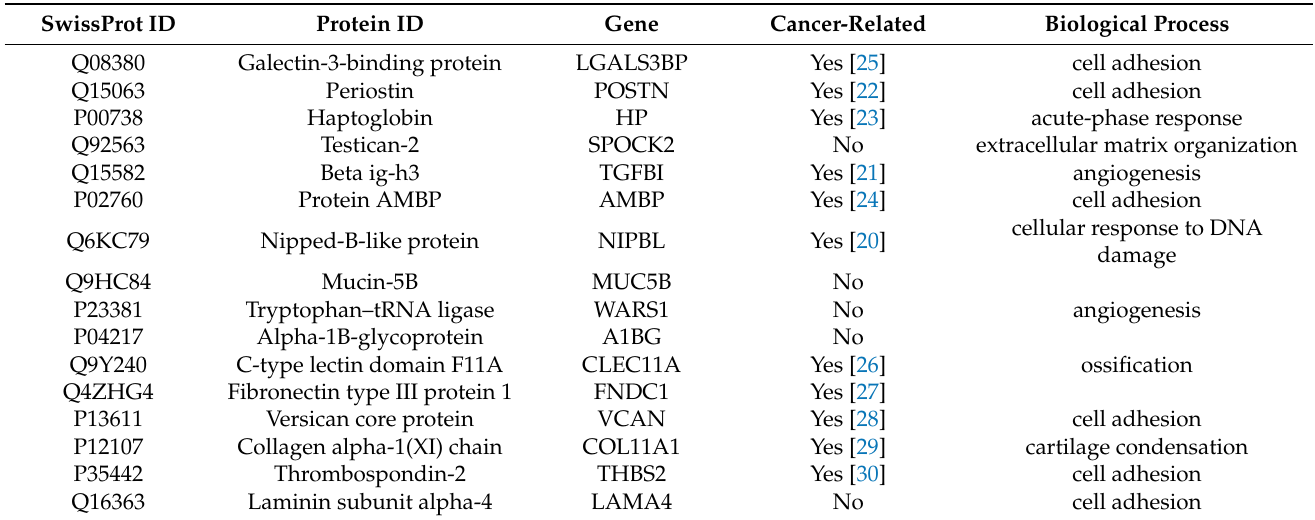
Table 5. Proteins included in the classifiers for either MPM or subtype classification. Proteins are annotated with the associated gene ontology biological process and whether they have previously been shown to be related to either mesothelioma or other cancer